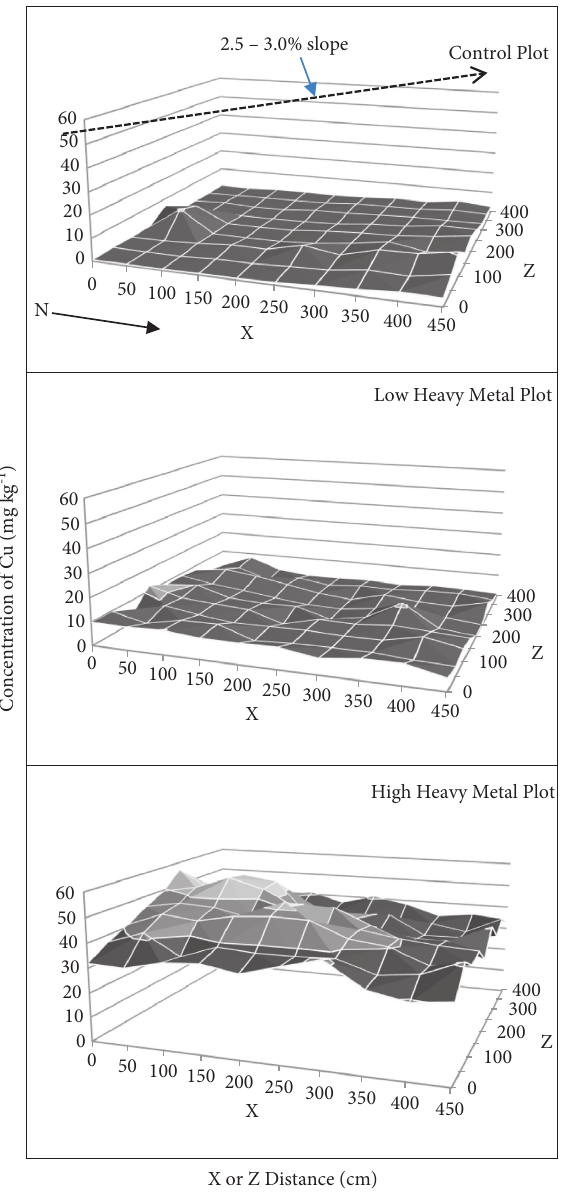
Figure 9: The horizontal spatial distribution of Cu in the waste- treated plots 21 years after amendment (control plot � 0, low metal plot � 15, and high metal plot � 60Mg waste ha − 1 ; plots measured 450cm ( X ) x 400cm ( Z